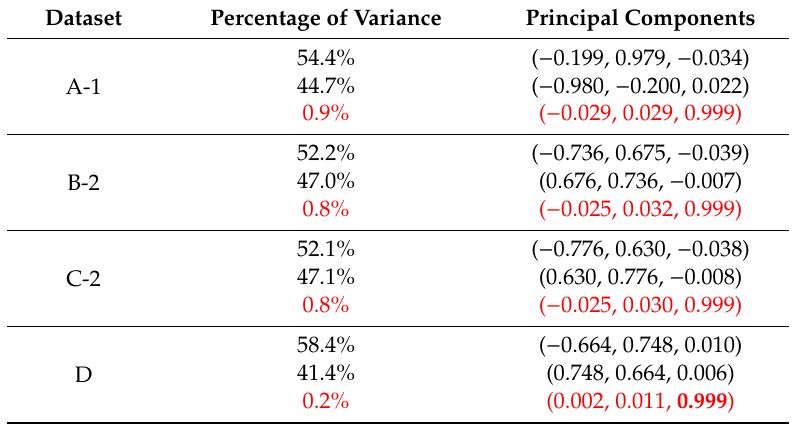
Table 7. Principal component analysis (PCA) of the dispersion matrix from least squares adjustment (LSA) when solving for the discrepancy between the image-based dense point cloud and LiDAR data for the A-1, B-2, C-2, and D datasets (third principal components indicating the direction of most reliable discrepancy estimates and corresponding variance percentages are colored in